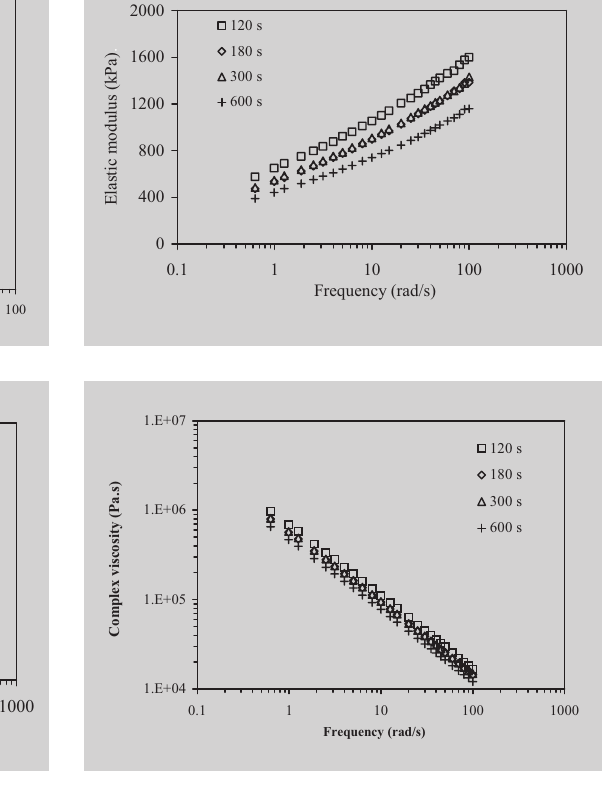
Figure 3 (left above): Elastic modulus, G’, of filled vulcanised CPE/NR blends with various mixing time as a function of deformation strain at low (1 rad/s) and high (100 rad/s) frequency. Figure 4 (right above): Elastic modulus, G’, of filled vulcanised CPE/NR blends with various mixing time as a function of frequency. Figure 5 (left below): Loss modulus, G’’, of filled vulcanised CPE/NR blends with various mixing time as a function of frequency. Figure 6 (right below): Complex viscosity, h *, of filled vulcanised CPE/NR blends with various mixing time.